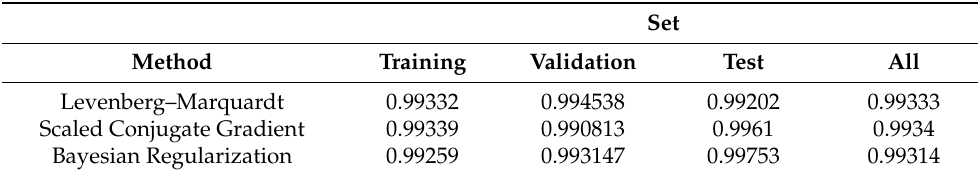
Table 4. Zigzags error measures ( r ).